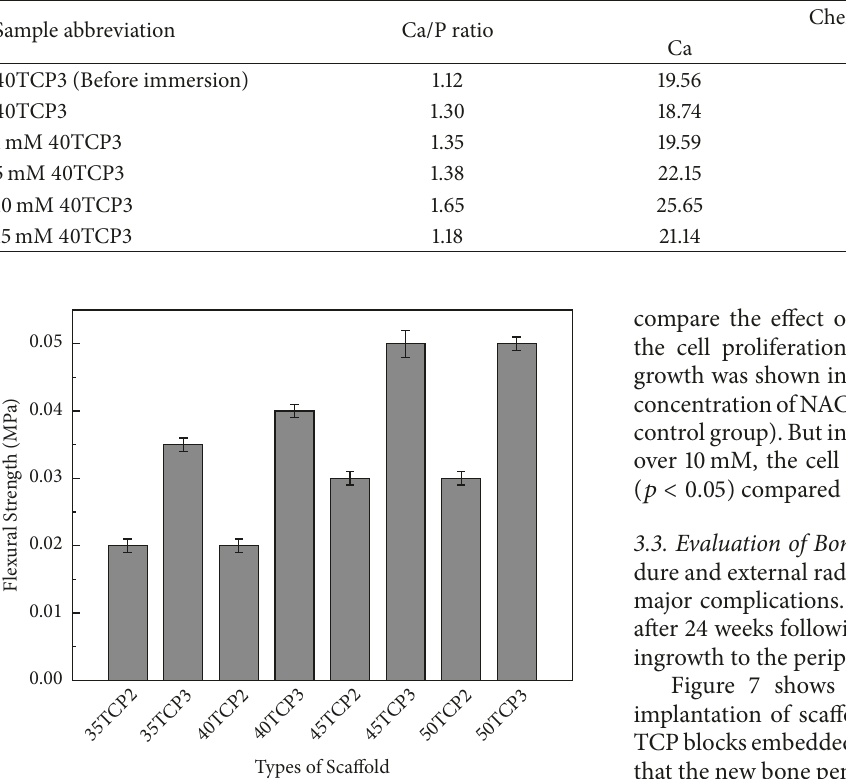
Table 1: Element composition of the scaffold after immersion in SBF for 14 days.